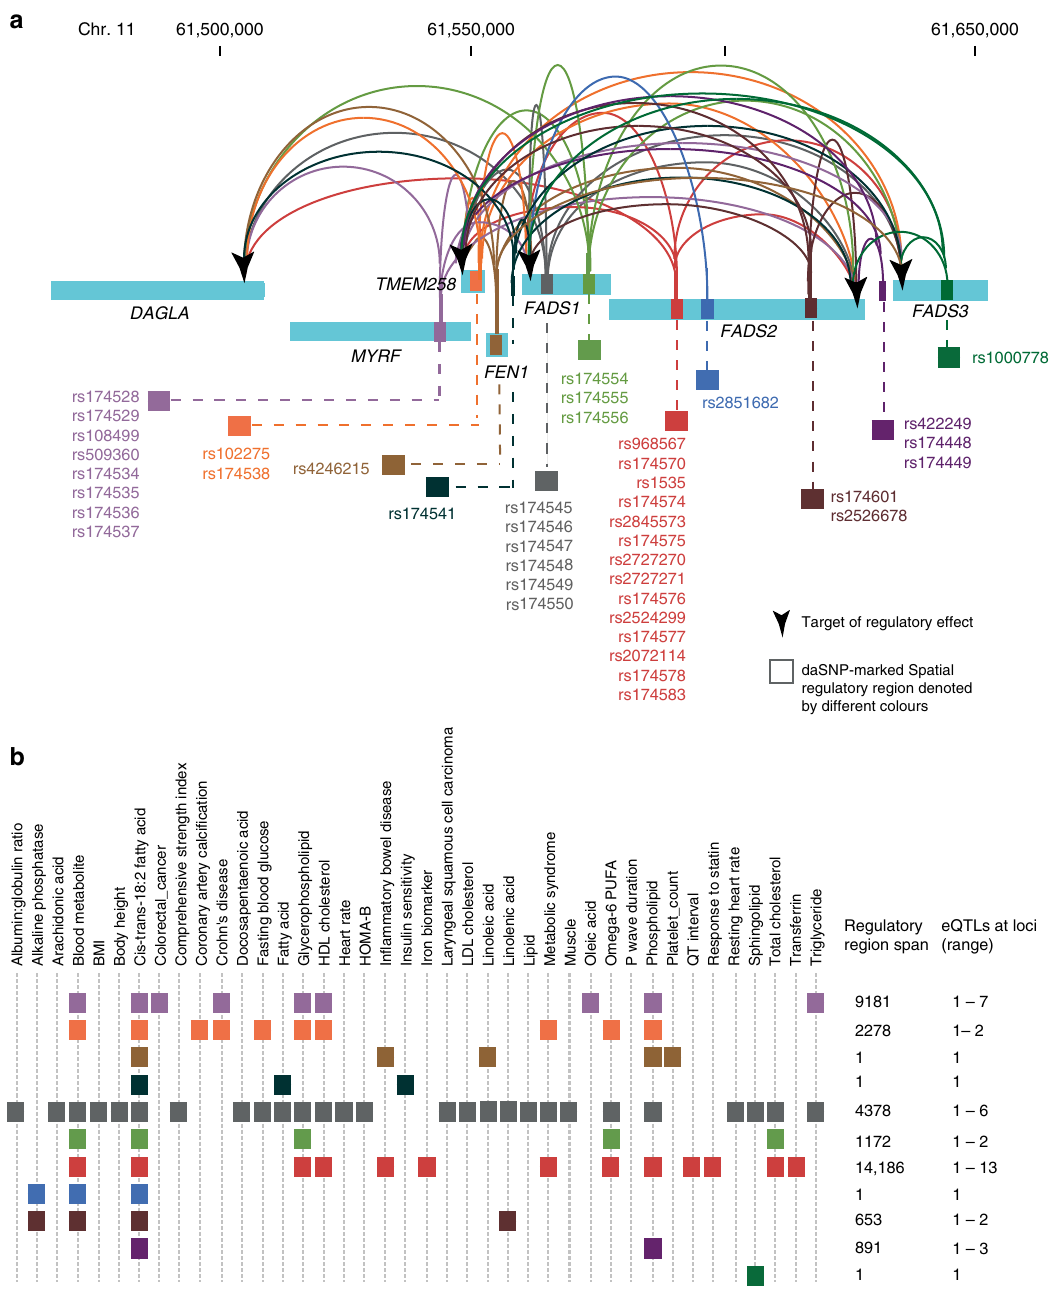
Fig. 3 Spatial eQTL-eGene interactions central to the fat metabolism cluster. a Transcript levels for genes located within Chr. 11: chr11:61447905 – 61659017 are associated with eQTLs located in clusters across the 283 kb locus. For simplicity, we grouped eQTLs according to separation in the linear sequence such that they are located in different genes, or are separated by ≤ 5 kb. Genomic locations are from human genome Hg19 and the eQTL-eGene interaction analysis used GTEx v4 (18/10/2016). b Phenotype-associated eQTLs are localised or dispersed across the FADS1 locus. eQTLs associated with cis-trans- 18:2 fatty acid levels are the most dispersed. eQTLs rs174545-50 are associated with the most phenotypes. The regulatory region span (in bp) includes the spatial eQTL SNPs in the group. eQTL SNPs are coloured according to the putative regulatory regions in